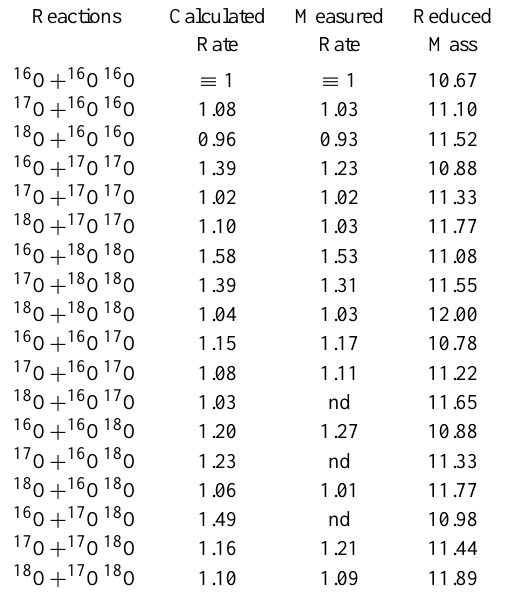
Fig. 8. Specific rates coefficients for isotopomer as a function of the reduced mass for the reactions l O + m O n O ( l , m and n stand for mass 16, 17 or 18). Data (open disks) from Mauersberger et al. (1999) are shown with their error bars and calculated values are in black. The calculation is performed in the low pressure approxi- mation with a = + 0 . 3, b = − 3 . 5, c = + 10 and β = 1 . 20; see appendix.